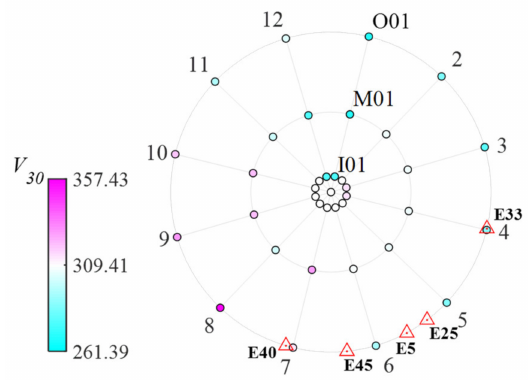
Figure 2. Layout of the SMART1 array.